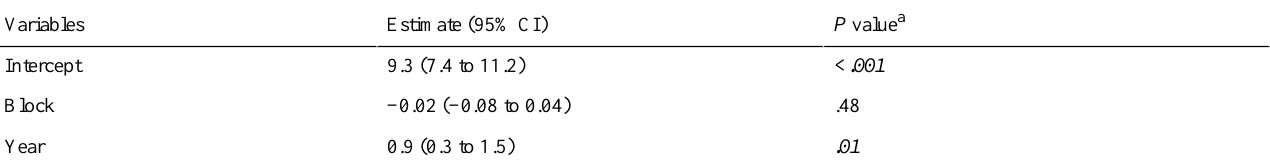
Table 5. Multiple linear regression showing the association of block with the objective structured radiology examination score, adjusting for the medical school